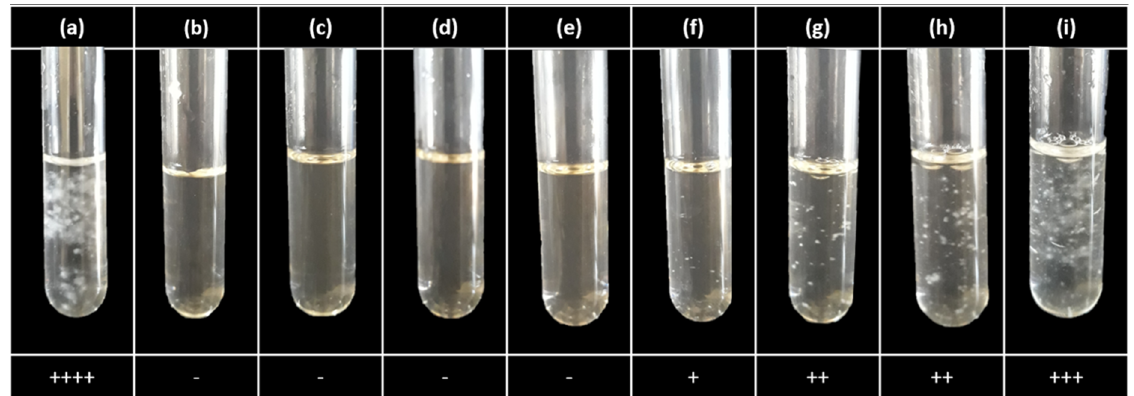
Figure 3. Dilution test in the broth for obtaining CMI from AgNPs, synthesized by the green route, on Fol, after 3 days of incubation. ( a ) Fol; ( b ) fungicide (Captan 2500 mg/L); ( c ) 150 mg/L; ( d ) 100 mg/L; ( e ) 75 mg/L; ( f ) 50 mg/L; ( g ) 40 mg/L; ( h ) 30 mg/L; ( i ) 20 mg/L. ++++ control-like growth (0% inhibition), +++ abundant growth (25% growth inhibition), ++ prominent decrease in growth (inhibition of 50%), + poor growth (inhibition of 75% growth), and ( − ) no visible fungal growth (100% inhibition) [34].